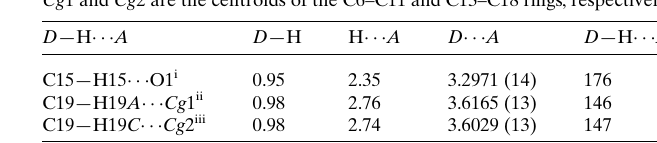
Table 1 Hydrogen-bond geometry (A˚ , (cid:2) ) for (I).